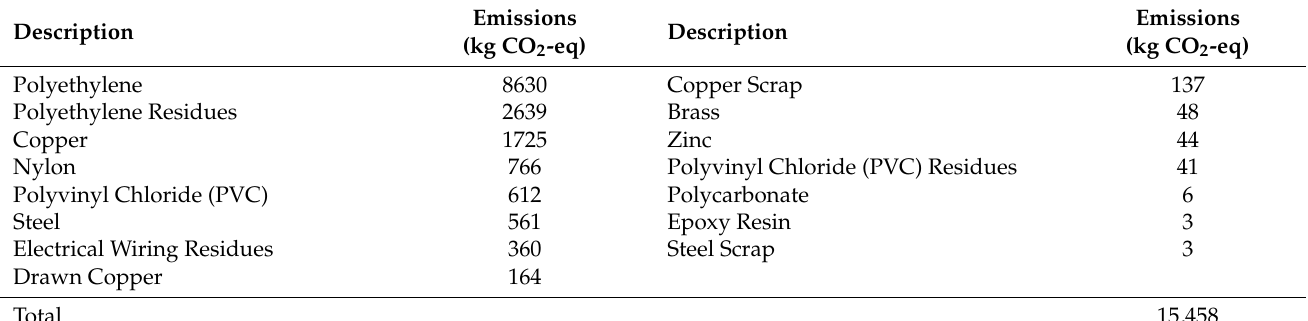
Table 7. GHG emissions associated with junction